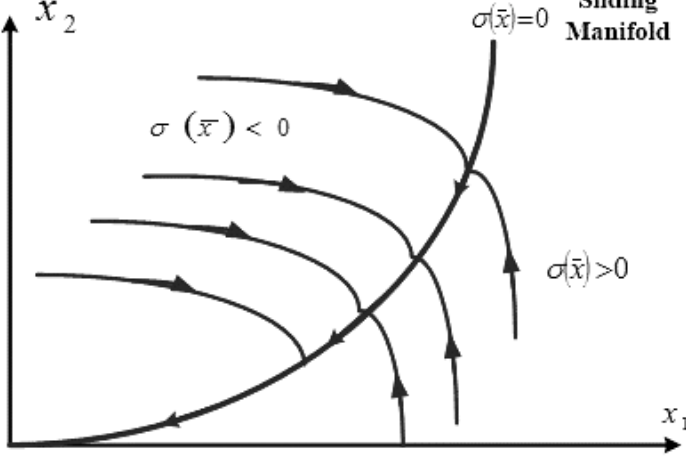
Figure 6. Vicinity of the switching surface.